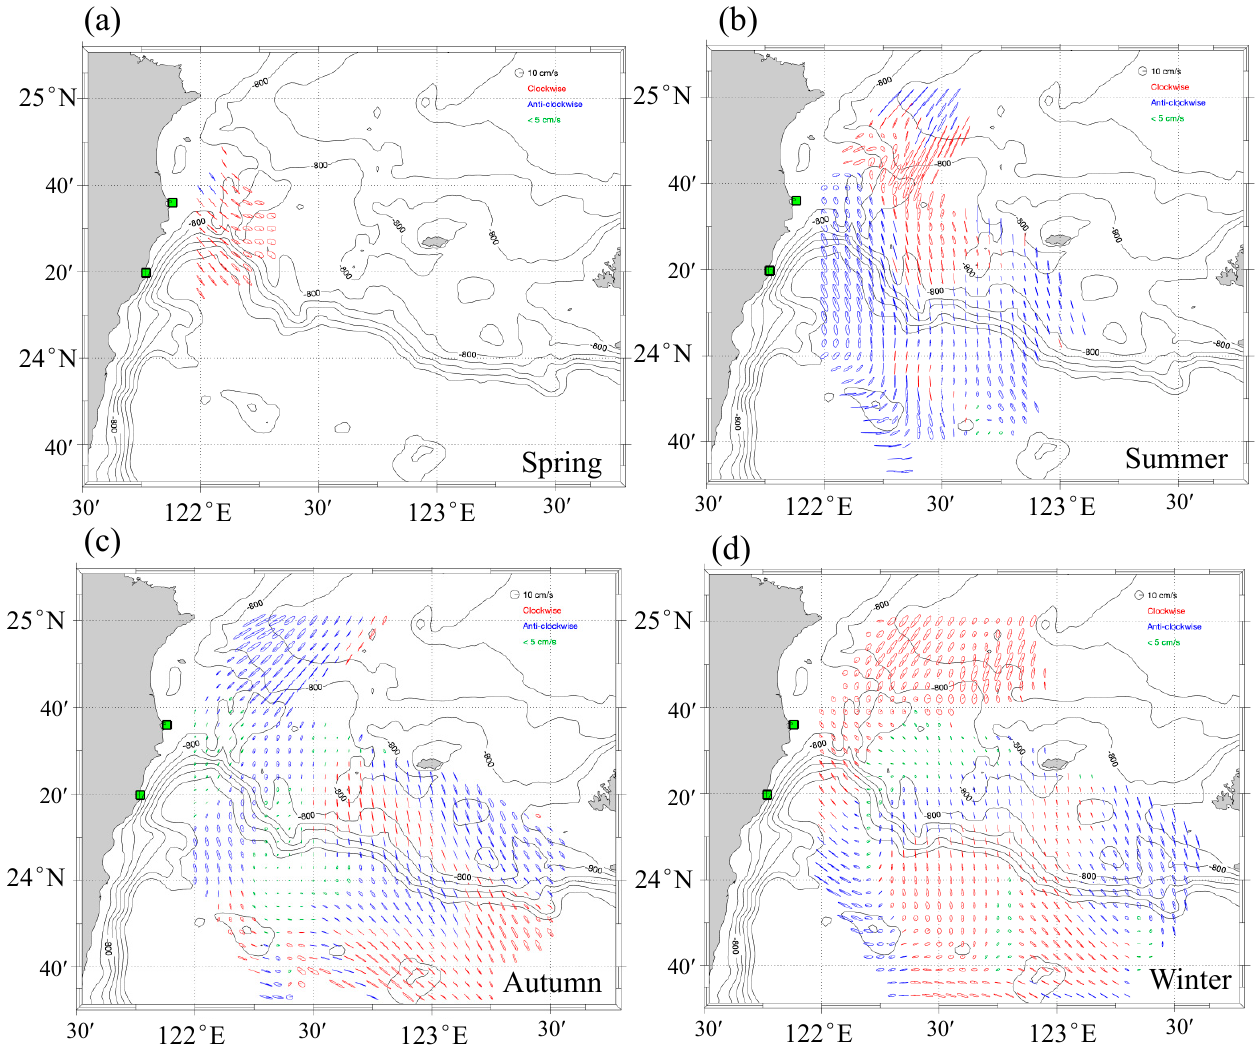
Figure 10. Current tidal ellipses for harmonic constituent MSf. ( a ) Spring, ( b ) Summer, ( c ) Autumn, and ( d ) Winter .